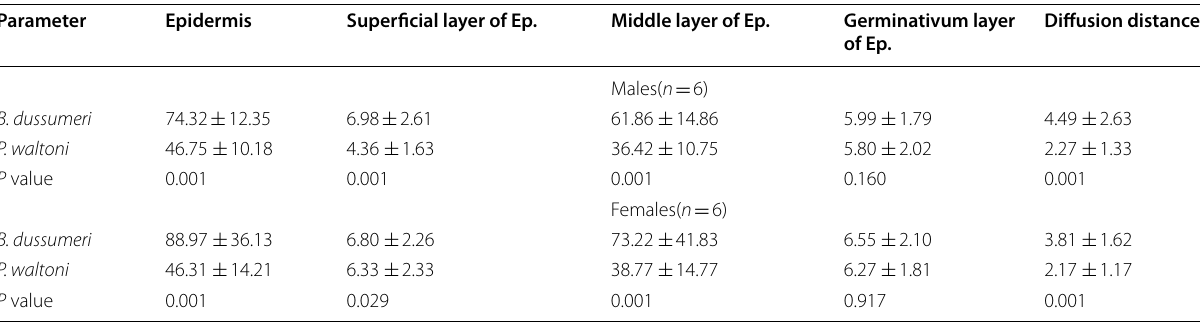
Table 2 The mean ( SD) thickness (μm) of the skin structural components in male and female B. dussumeri and P. waltoni ±